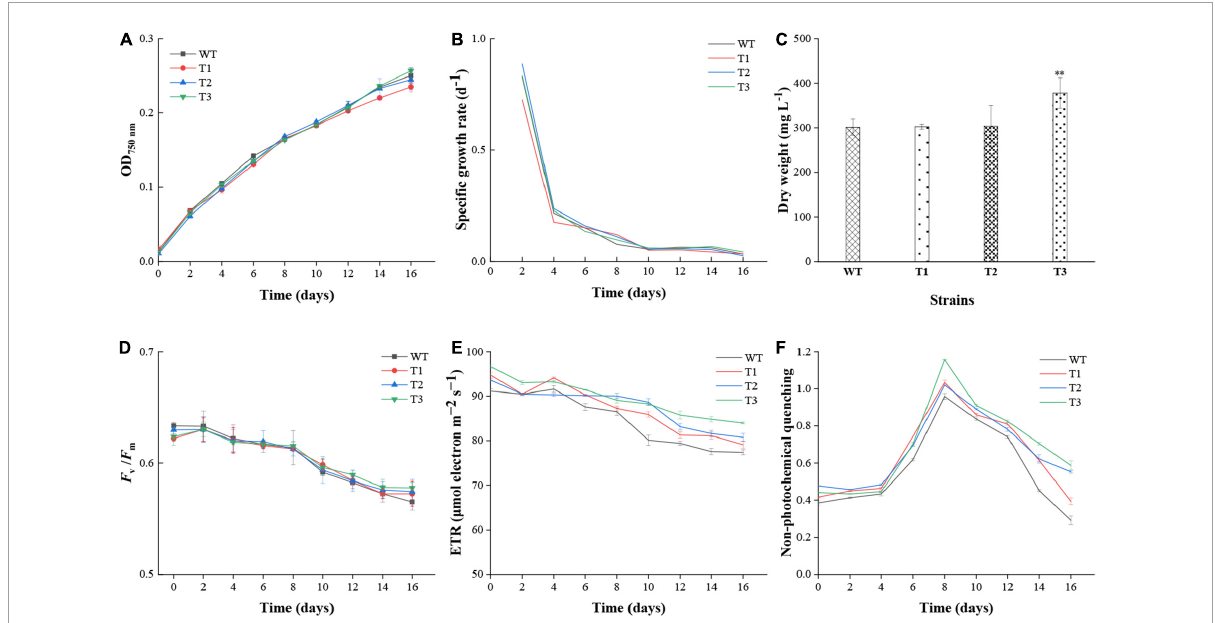
FIGURE4 Growth performance and chlorophyll fluorescence parameters of WT and transformants. (A–C) Cell density, specific growth rate, and biomass of WT and transformants. (D–F) F v / F m , photosynthetic electron transport rate (ETR), and non-photochemical quenching (NPQ) of WT and transformants. **Indicates a highly significant difference ( p < 0.01).